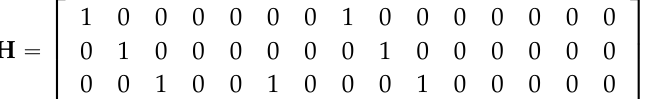
Figure 10. A simplified model of underwater sound transmission.